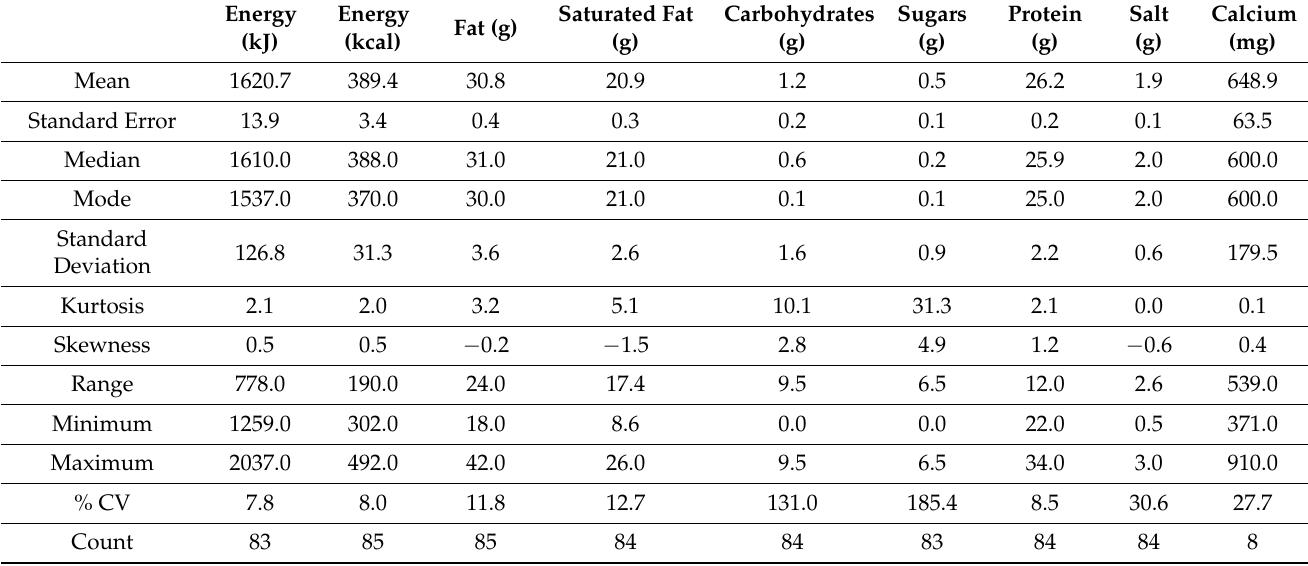
Table 2. Descriptive Statistics of nutrients’ concentrations (per 100 g) of pre-packed graviera cheese products in the Greek market.